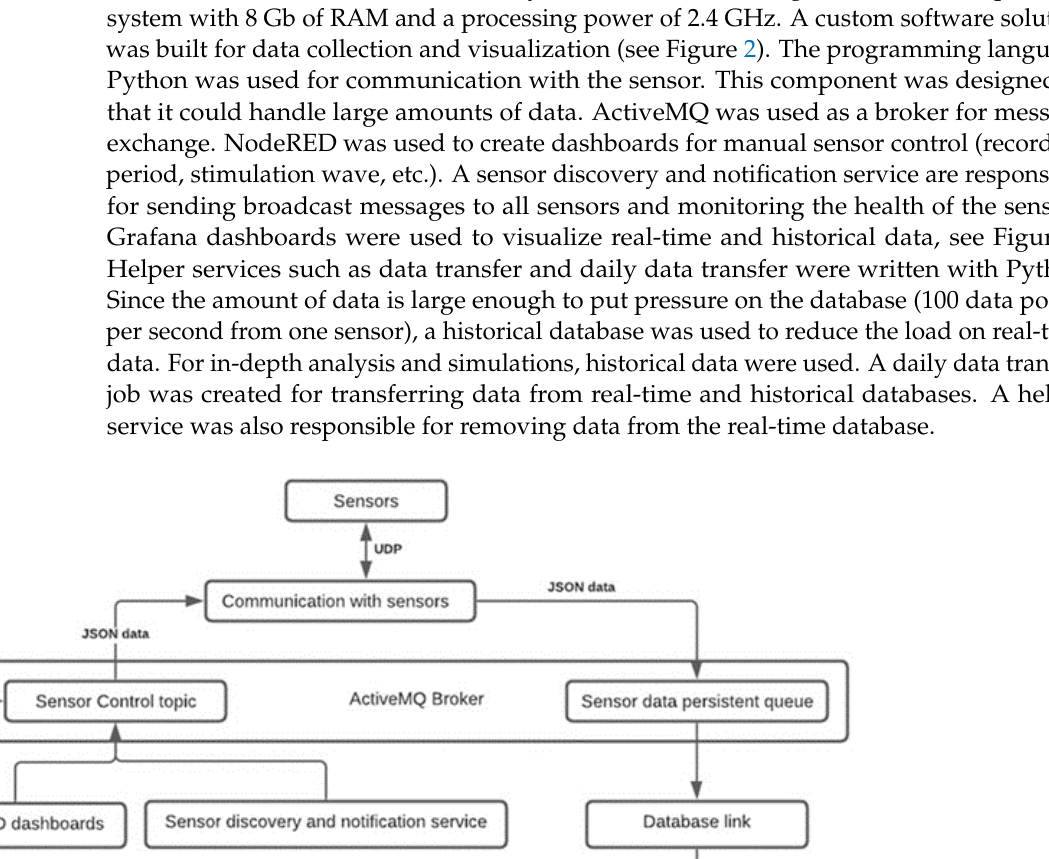
Figure 3. Ten seconds of calibrated data. The data analysis component is responsible for pulse measurement, breathing rate measurement, and automatic sensor control. The pulse and breathing rates were meas- ured by smoothing data using Gaussian kernels with different kernel bandwidths (20 for breathing rate extraction and 10 for pulse rate smoothing). The changes in blood pressure could also be monitored and stimulation parameters could be adjusted automatically in a closed-loop manner. 2.3. Device Peripherals The arterial catheters (Figure 4) were made of a polyethylene tube (Smiths Medical International Ltd., external diameter 0.96 mm, internal diameter 0.58 mm) with additional ports to replace lock solutions and sensor calibration. An anchor was fixed at 24–26 mm from the catheter tip and acted as a stopper and a securing device that positioned the catheter tip at the junction of the common carotid artery and aortic arch. Either 500 IU heparin/99.7% glycerol or 500 IU heparin/50% dextrose solutions were used for catheter lock solutions. Electrodes made of stainless-steel wire of 100 µm in diameter with polyamide insula- tion of 5 µm (Goodfellow Cambridge Ltd., Huntingdon, UK) were used. The electrodes were produced in a bipolar fashion with 200 µm overhang between the tips. The jackets for the rats were made from neoprene fabric with Velcro straps, and the device case was 3D printed (Ender-3 Pro, Creality) from polylactic acid plastic (Fiberology).